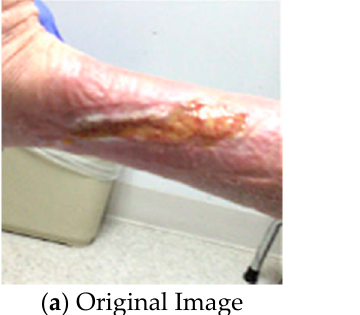
Figure 11. The probabilities of wound types: Pressure injury: 27.3%, lymphovascular: 12%, surgical: 2.6%, diabetic: 58.2% (Pressure injury).